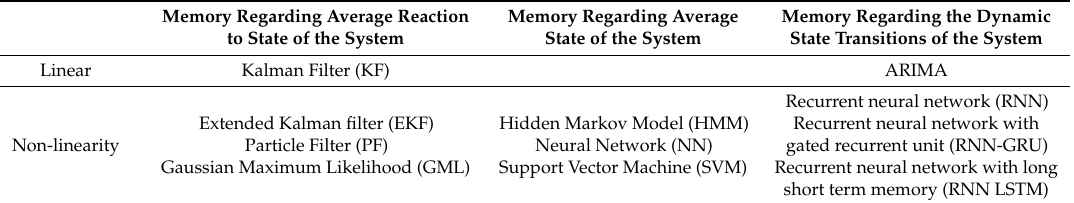
Table 1. Categorization of mathematical techniques for traffic